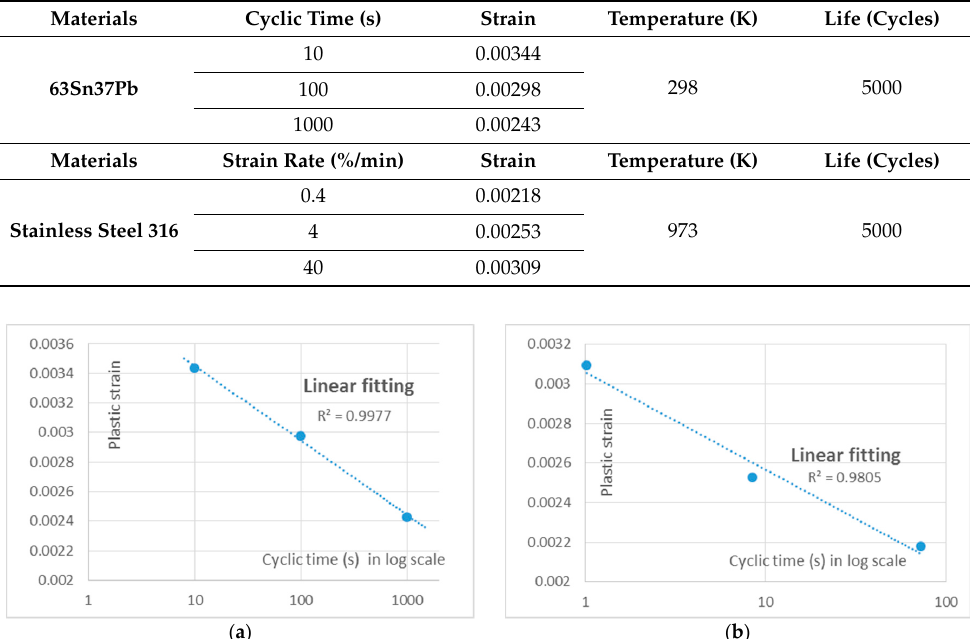
Table 2. Data of cyclic time/strain rate-strain relation for 63Sn37Pb [21] and SS316 [51].